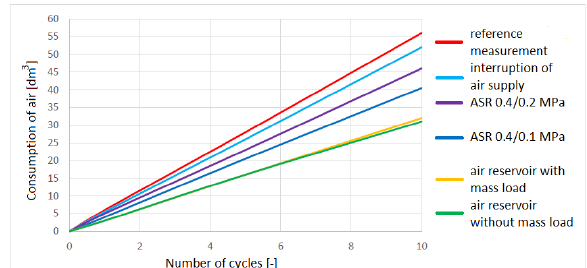
Fig. 16. Graph of consumption of compressed air for working pressure 0.4 𝑀𝑃𝑎